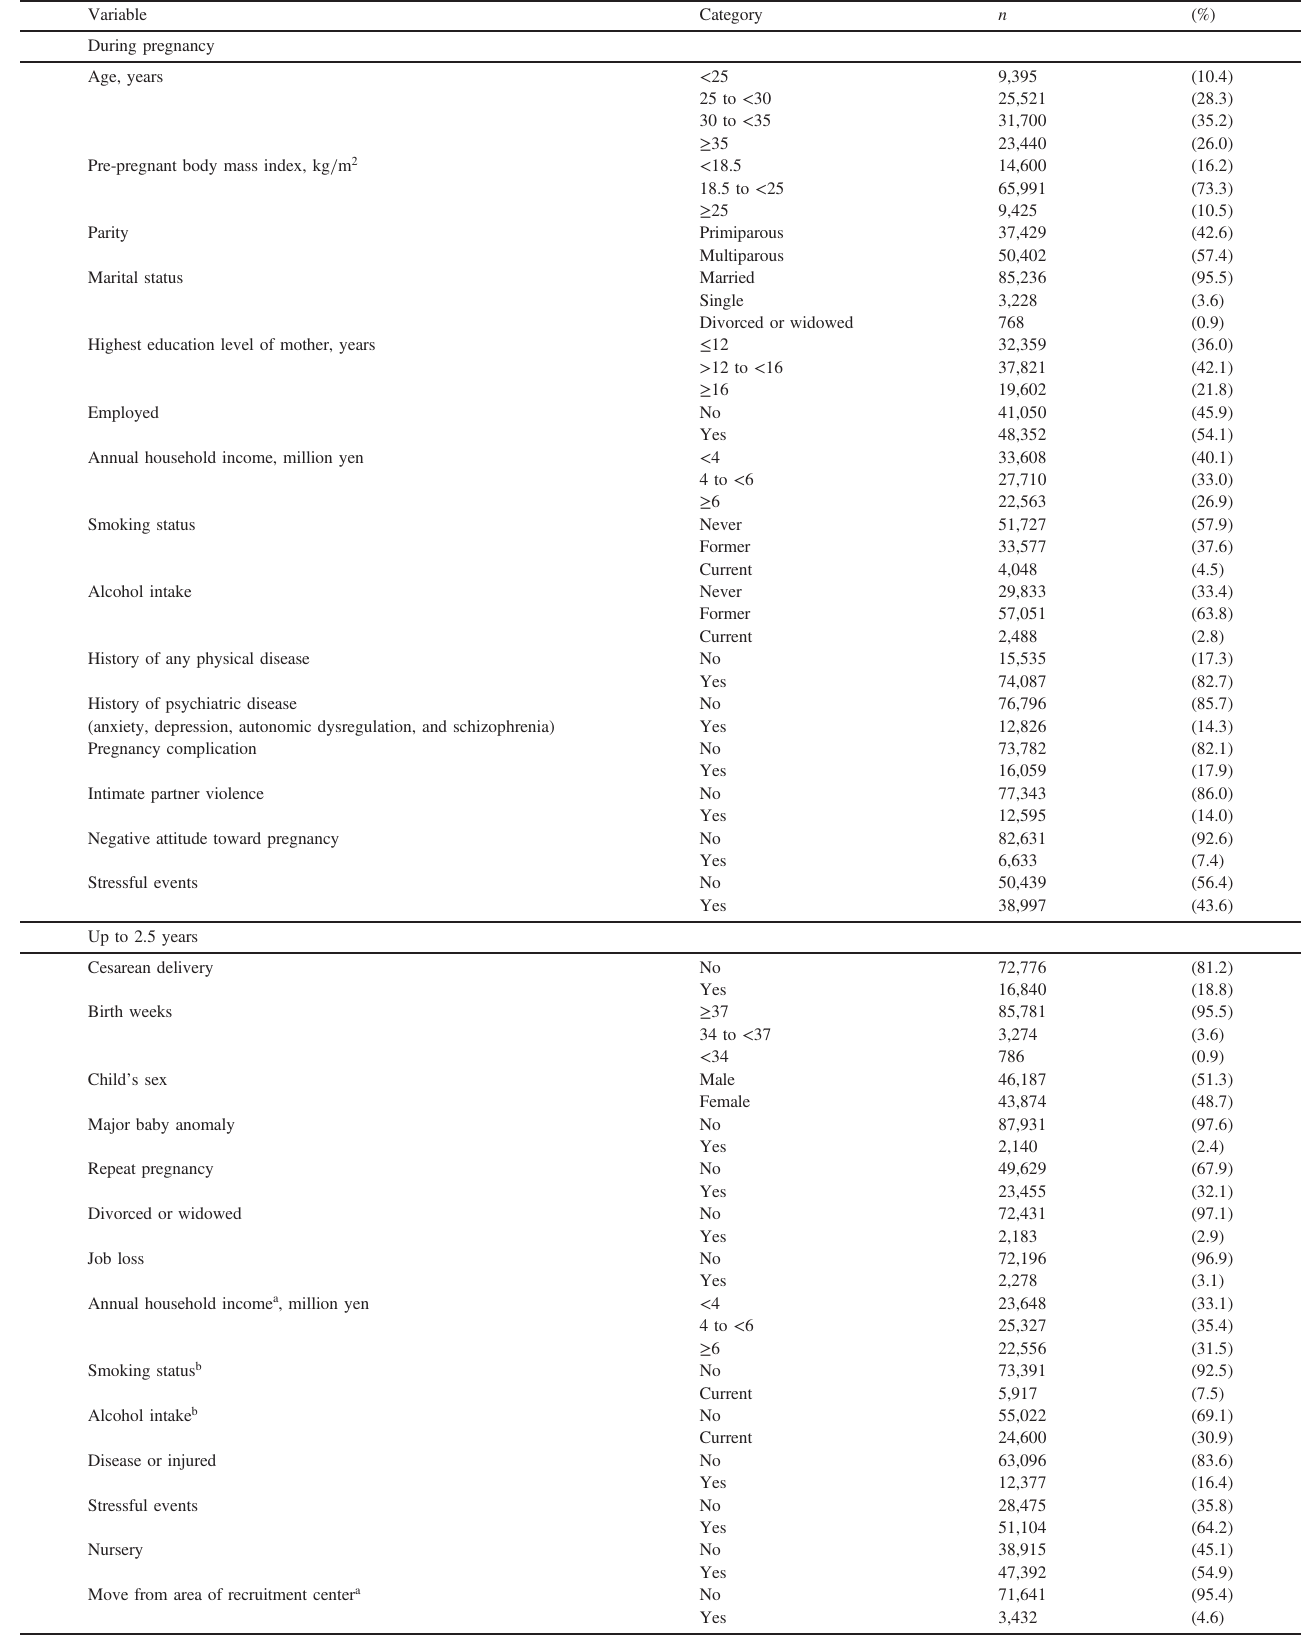
Table 2. Participants ’